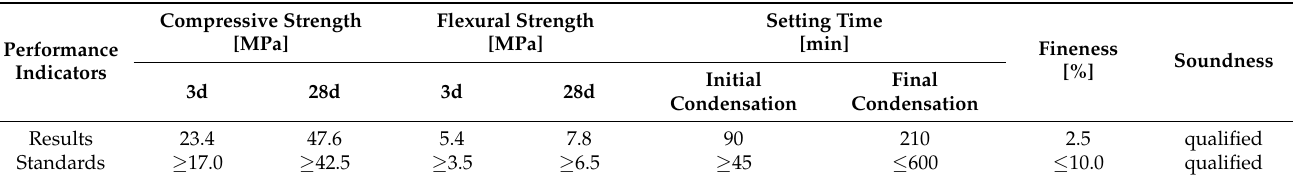
Table 2. Test results of cement performance indices.